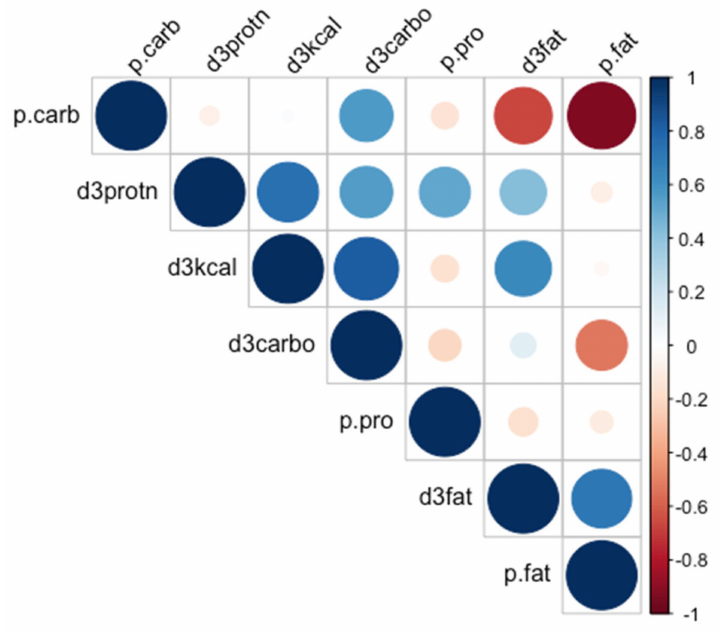
Figure 2. Correlations among total daily energy intake, macronutrient intakes, and relative macronu- trient intakes. P.carb, percentage of daily energy from carbohydrate; p.pro, percentage of daily energy from protein; p.fat, percentage of daily energy from fat; d3carbo, three-day average intake of carbohydrate (g); d3fat, three-day average intake of fat (g); d3protn, three-day average intake of fat